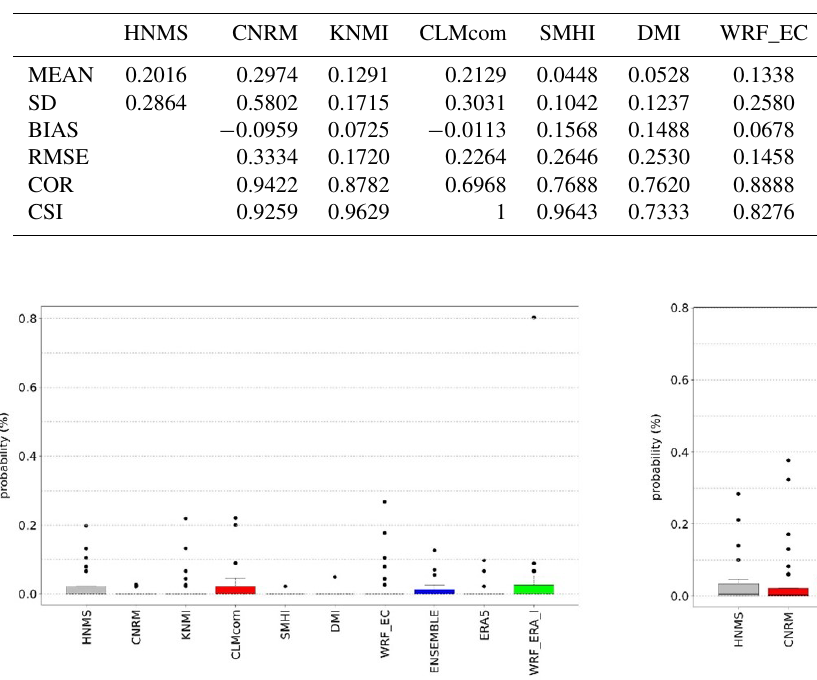
Table 5. Table exhibiting mean (MEAN) RR20FD copula station probabilities (%) for observations and models, standard deviation (SD), bias (BIAS), rmse (RMSE), Pearson correlation (COR), and CSI of models against observations.